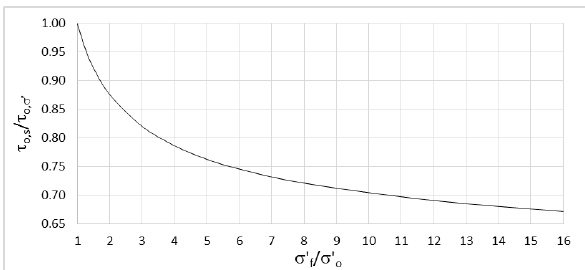
Fig. 2 Ratio τ o , s / τ as a function of σ (cid:48) f / σ (cid:48) o for the extended model of Davis and Raymond with both non-constant c v o , σ (cid:48) and 1+e and variable